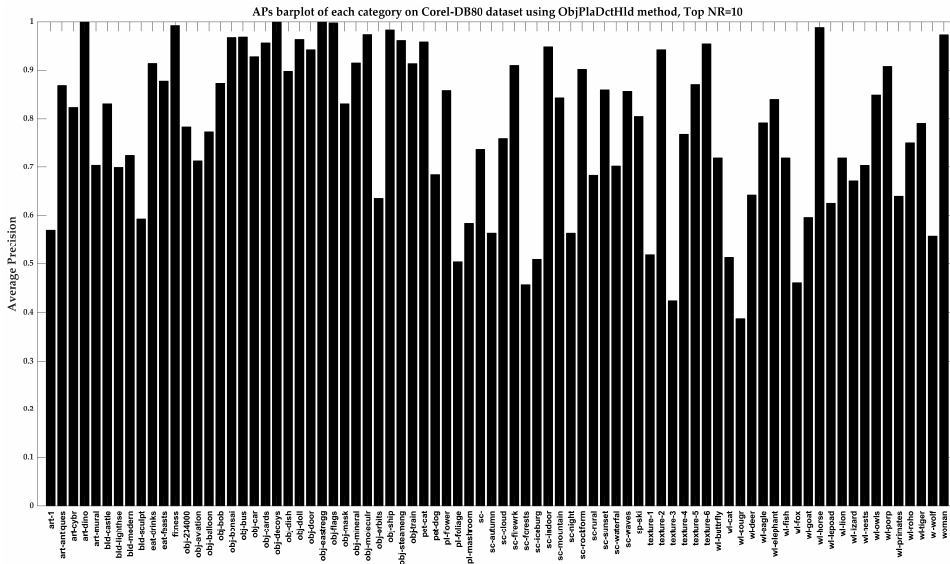
Figure 14. APs bar plot of each category on the Corel-DB80 dataset using the proposed method with Top NR = 10.